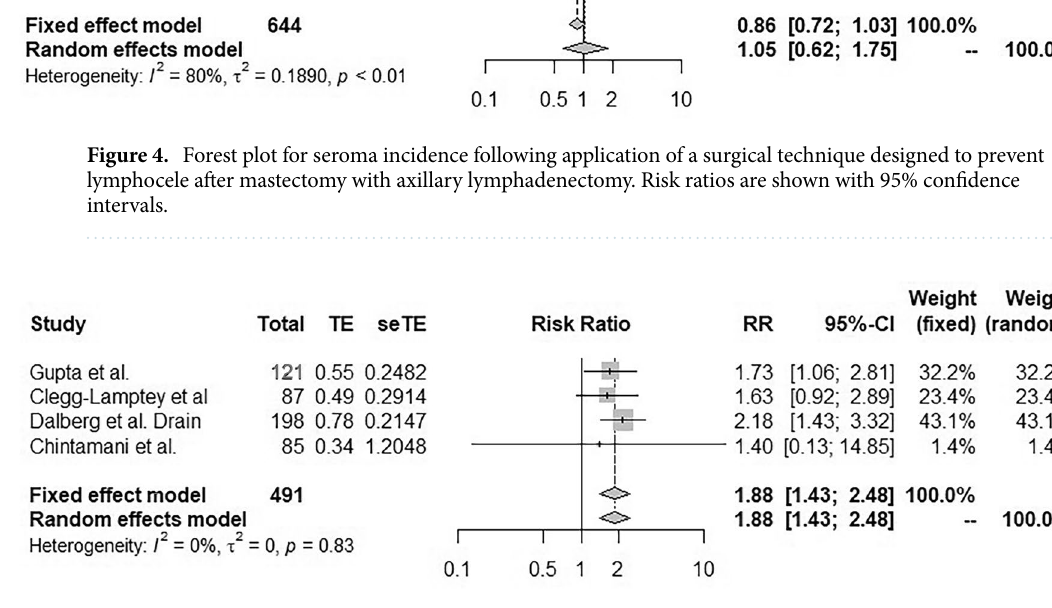
Figure 5. Forest plot for seroma incidence following application of a modified drainage method designed to prevent lymphocele after mastectomy with axillary lymphadenectomy. Risk ratios are shown with 95% confidence